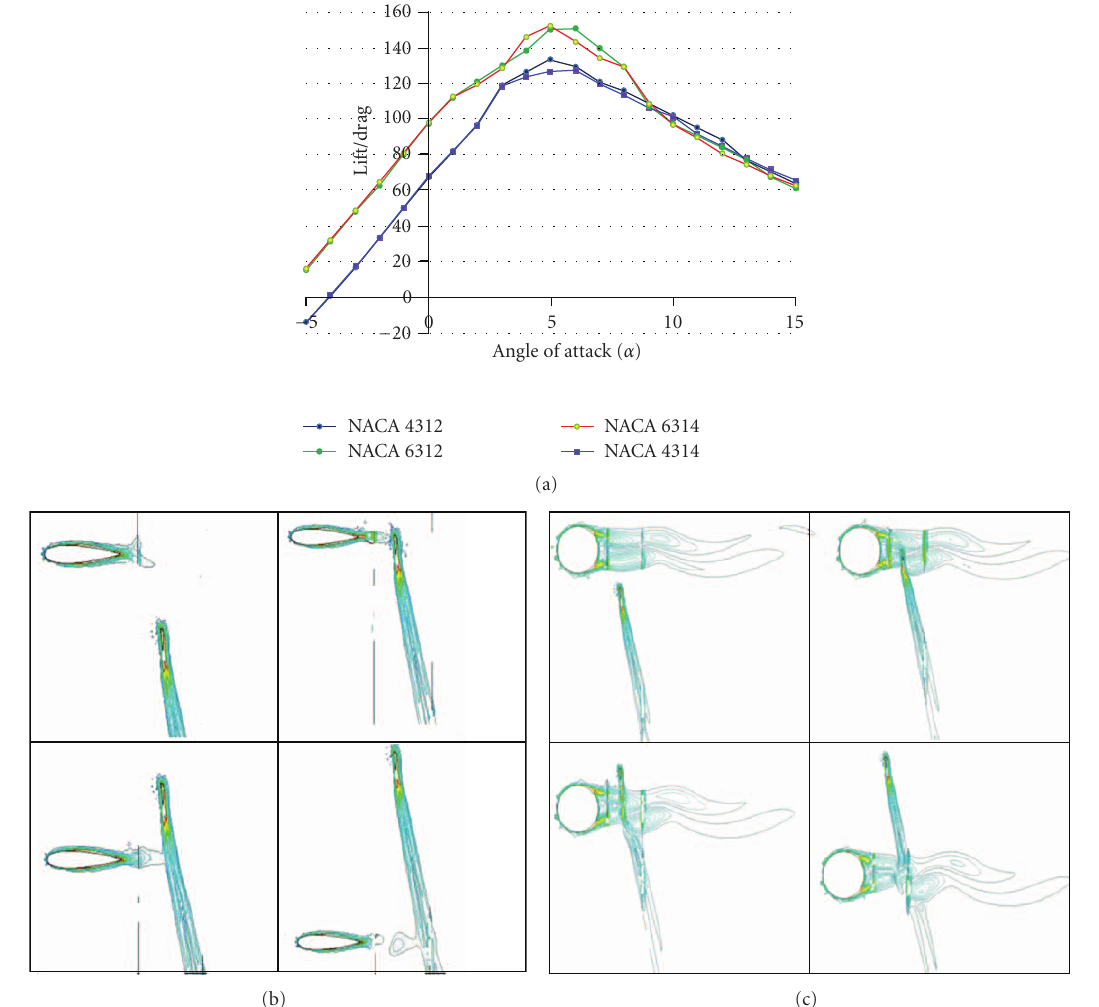
Figure 6: (a) Lift-to-drag ratio for di ff erent rotor airfoils. (b) Vorticity contours at di ff erent stages of the rotor cycle. The rotor speed is quadruple the speed of the incoming wind. (c) Vorticity contours during the passage of